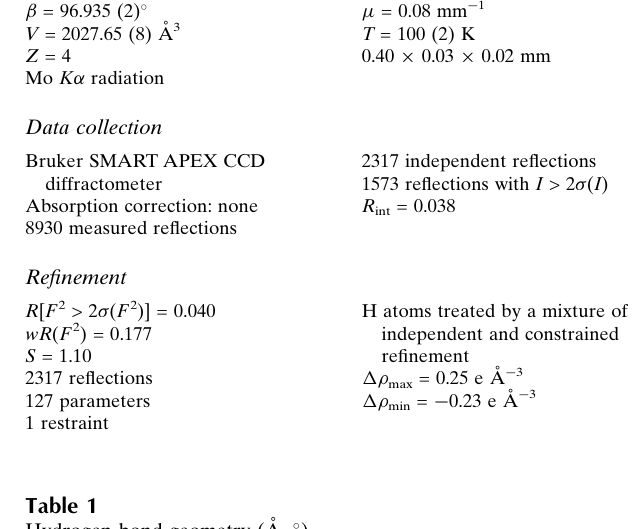
Hydrogen-bond geometry (A˚ , (cid:2)